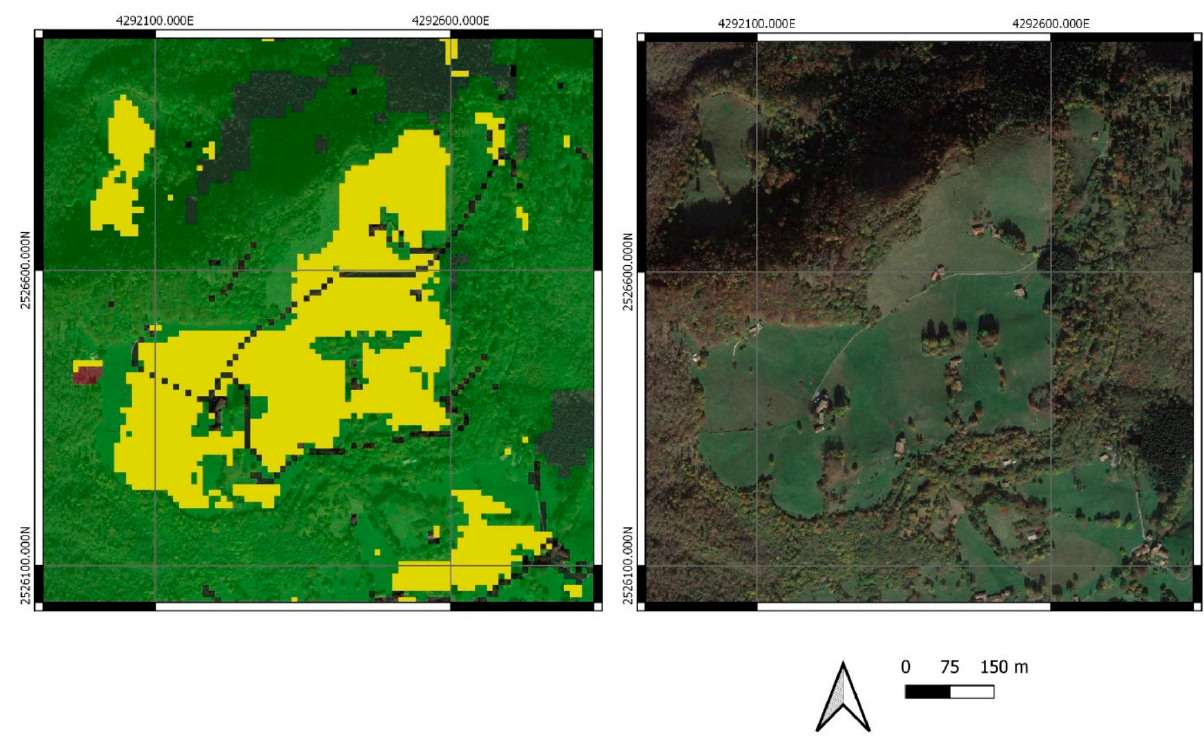
Figure 11. Permanent herbaceous.